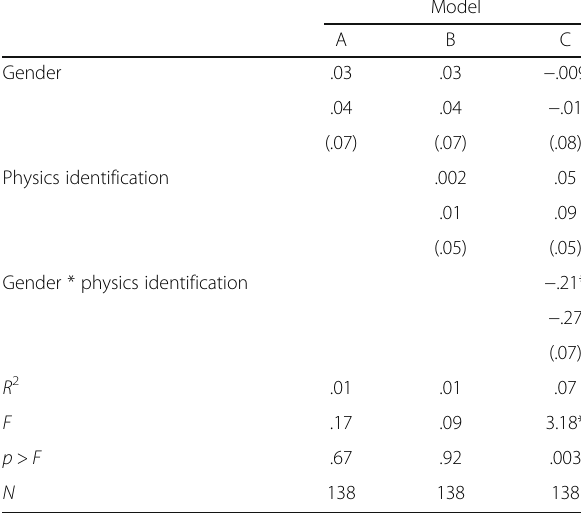
Table 6 Regression models for gender and physics identification on flourishing